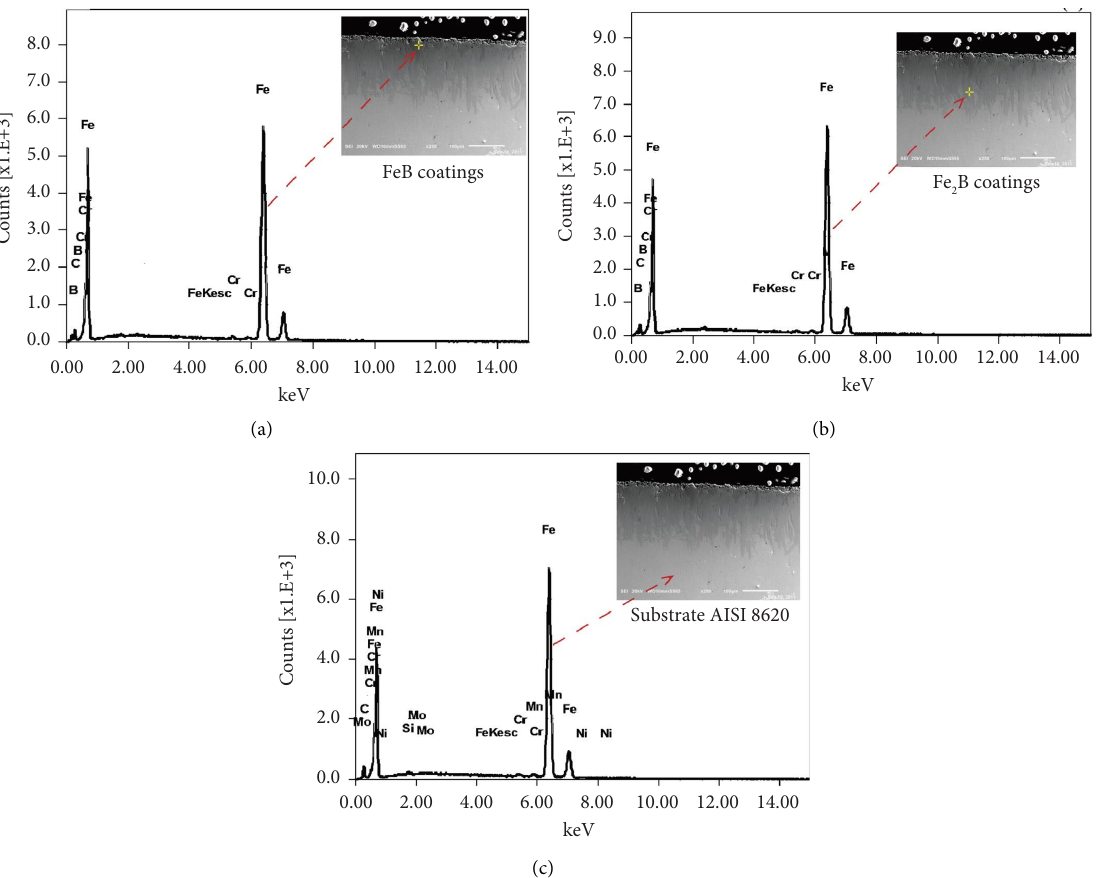
Figure 6: EDS spectrum of AISI 8620 borided steel at 1223K on: (a) FeB coating, (b) Fe